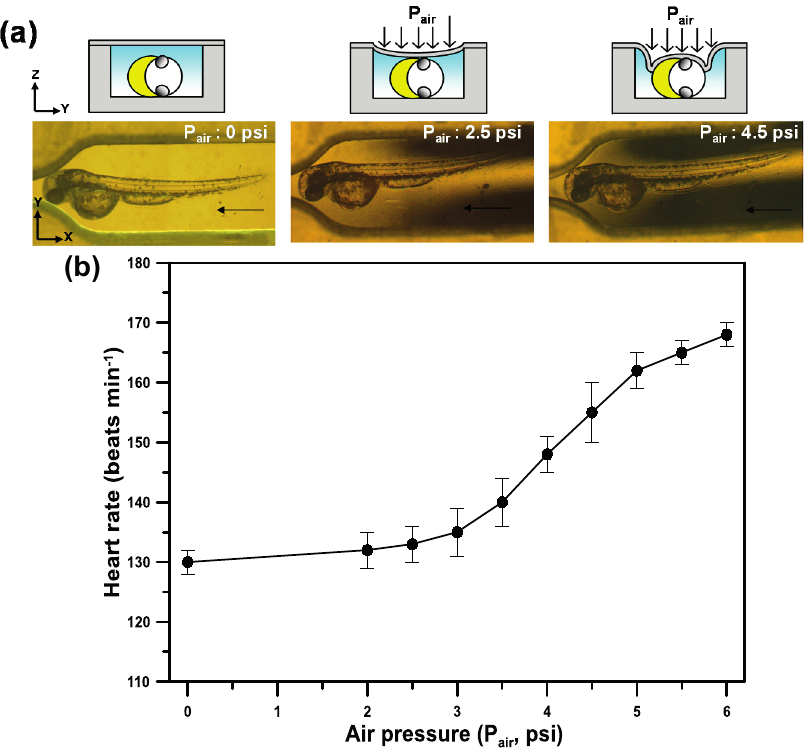
Figure 5. ( a ) The optical images and ( b ) the heart rate (beats min − 1 ) of 48 hpf zebrafish embryos immobilized on its lateral side by using a pneumatically actuated membrane at different air